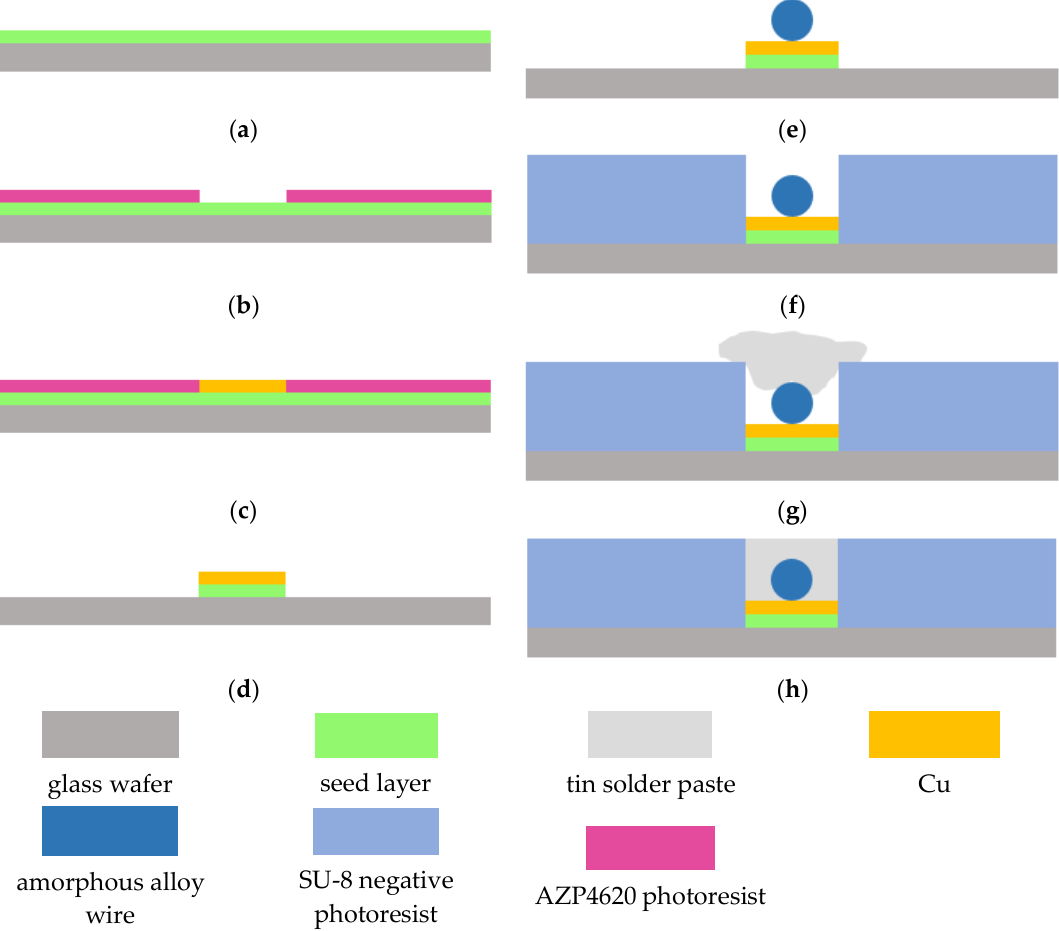
Figure 3. Fabrication process of the amorphous alloy wire magnetic sensor.